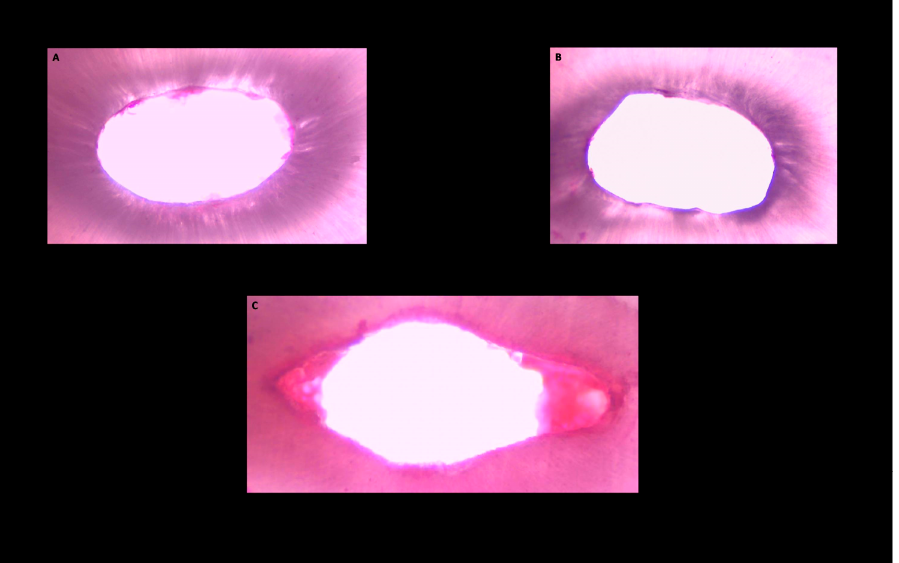
Figure 2. Histological images of the of the cross-sections obtained from the apical third of the root canal area after root canal preparation. Pulp tissue and microbial biofilm debris persisting and root canal wall protruding into the canal lumen (white) in ultrasonically activated (group A ), ultrasoni- cally activated preceded by intracanal heating (group B ) and traditionally applied (group C ) NaOCl groups.